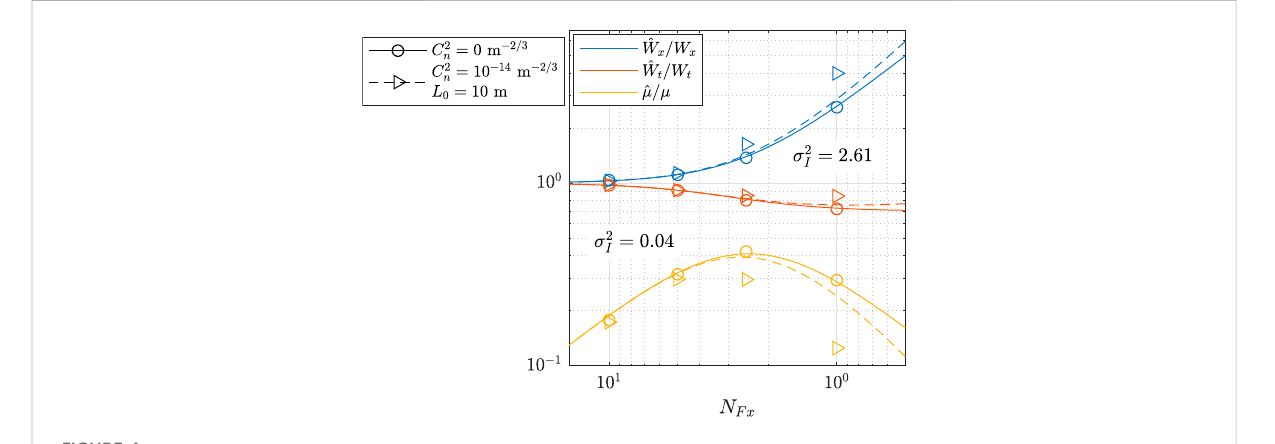
FIGURE 4 Theory [Eq. 19] and simulation ^ W x / W x , ^ W t / W t , and ^ μ / μ versus Fresnel number N Fx . The symbols ◦ and ⊳ are the results of the